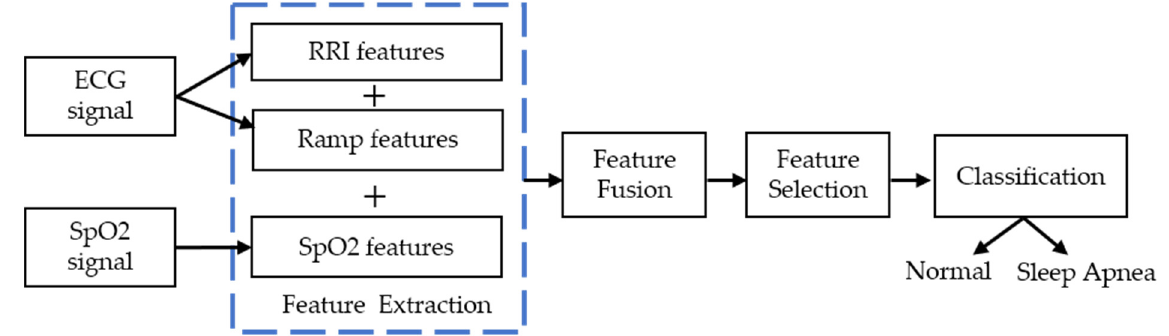
Figure 1. Block diagram of the automated sleep apnea detection algorithm.